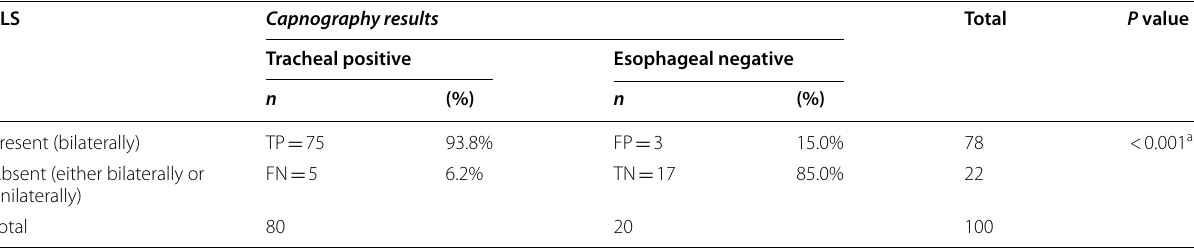
Table 3 Comparison of ultra-sonographic (SLS results) results with the continuous capnography waveform results